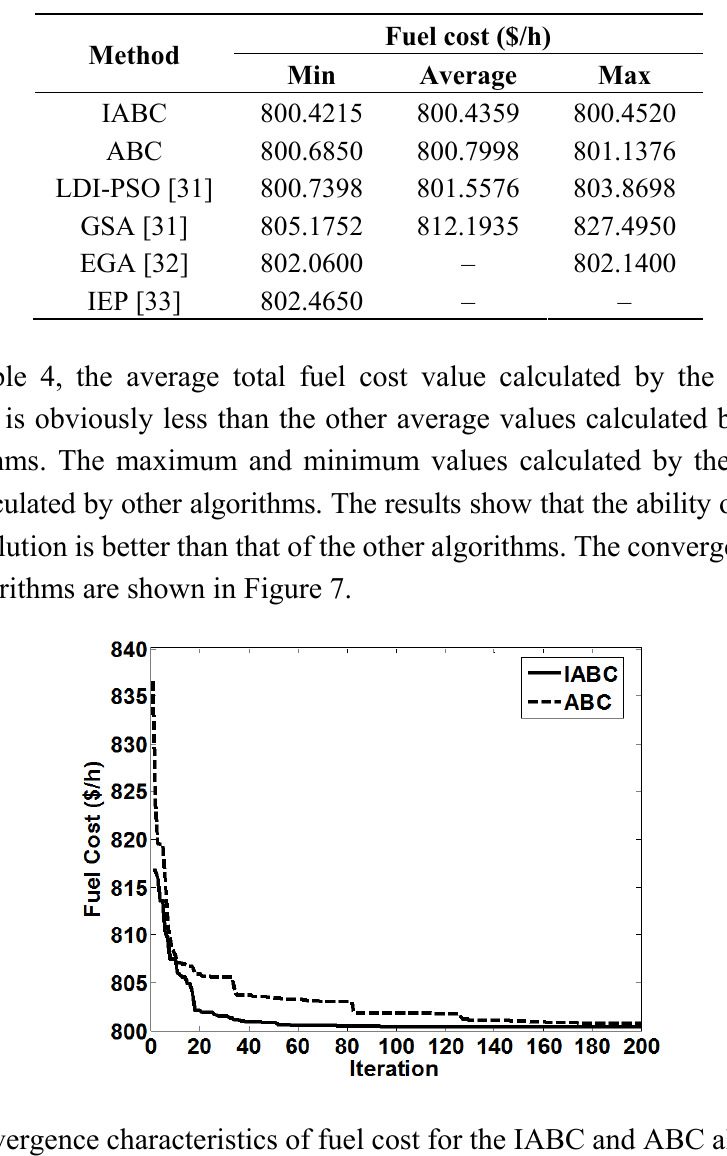
Table 4. Results obtained by different algorithms for OPF with total fuel cost.